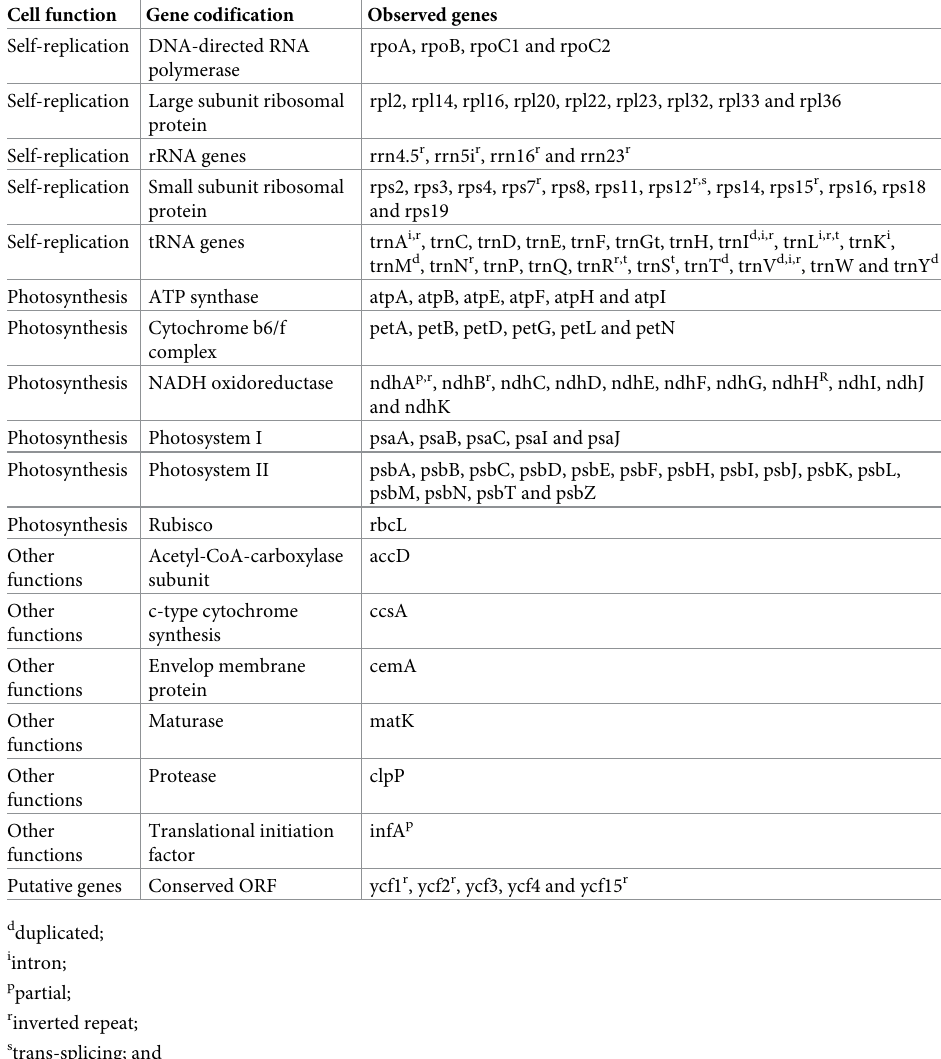
Table 2. Gene content in the assembled plastome of Ipomoea cavalcantei